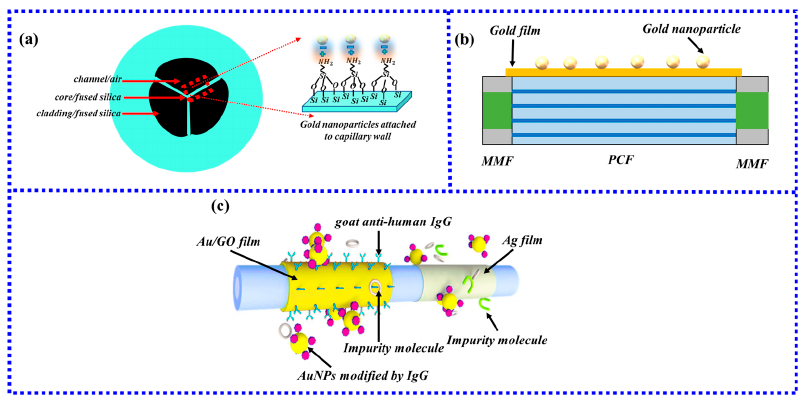
Figure 16. ( a ) Cross-sectional view of the MOF coated with gold nanoparticles on the inner wall. ( b ) Schematic diagram of the single-channel sensor structure; ( c ) Schematic diagram of the dual-channel sensor structure [105]. Copyright 2023, Elsevier.